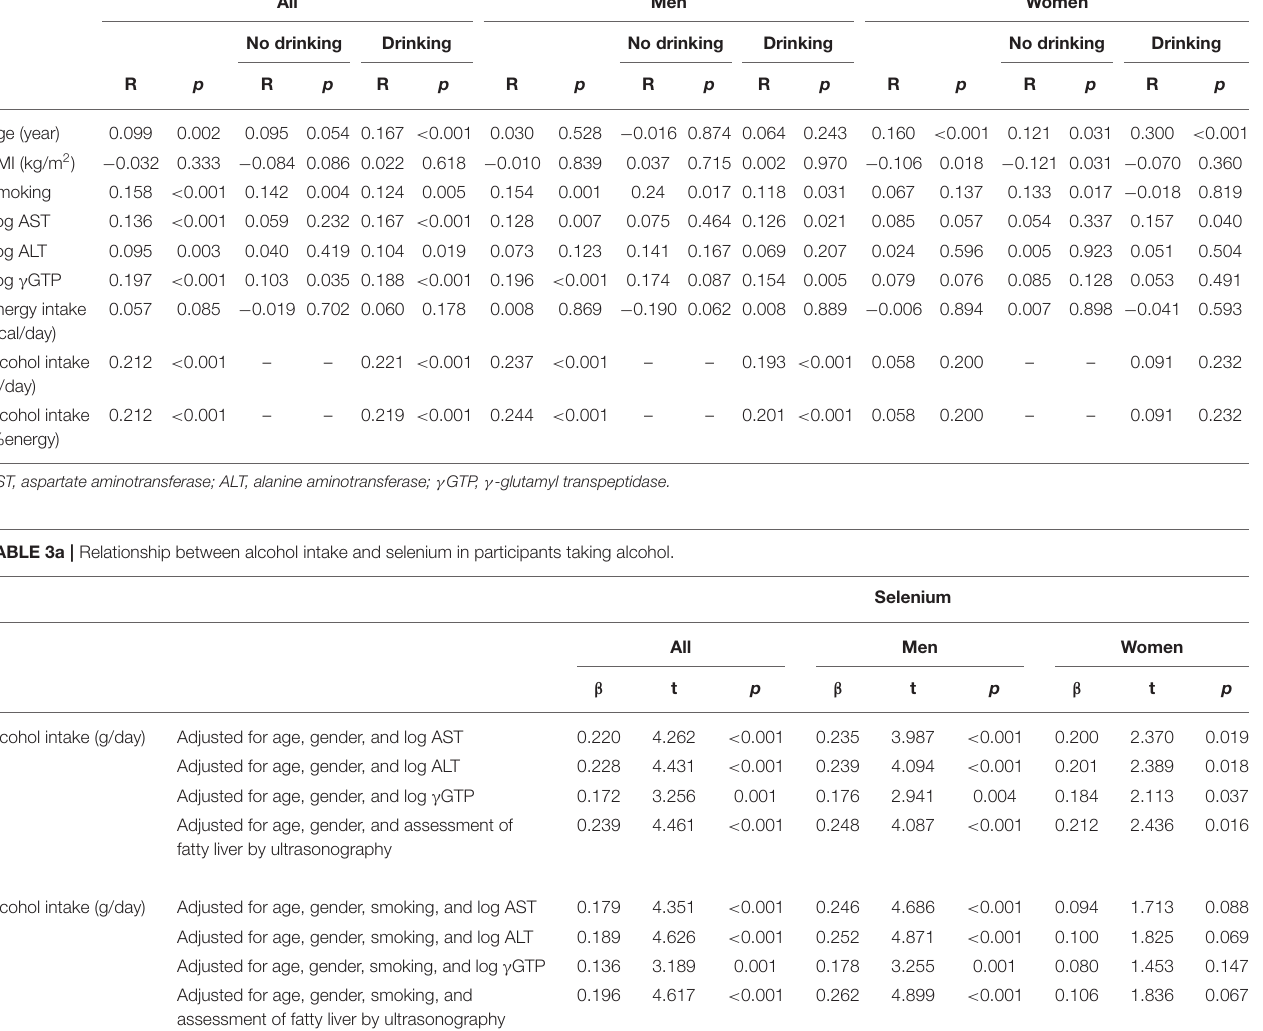
TABLE 2b | Univariate correlation between clinical parameters and selenoprotein P in participants consuming and not consuming alcohol. Selenoprotein P All Men Women No drinking Drinking No drinking Drinking No drinking Drinking